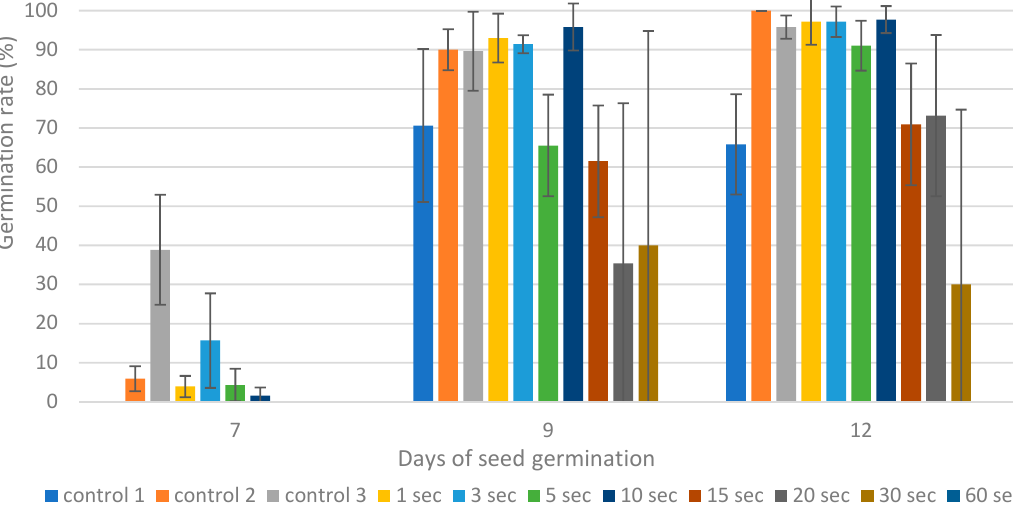
Figure 4. Germination rate of Scots pine seeds exposed to different times of non-thermal plasma treatment after the 4 th , 7 th , 9 th , and 12 th days of seed germination. Control 1, control 2, and control 3, see Figure 2. More details are given in the Methods.